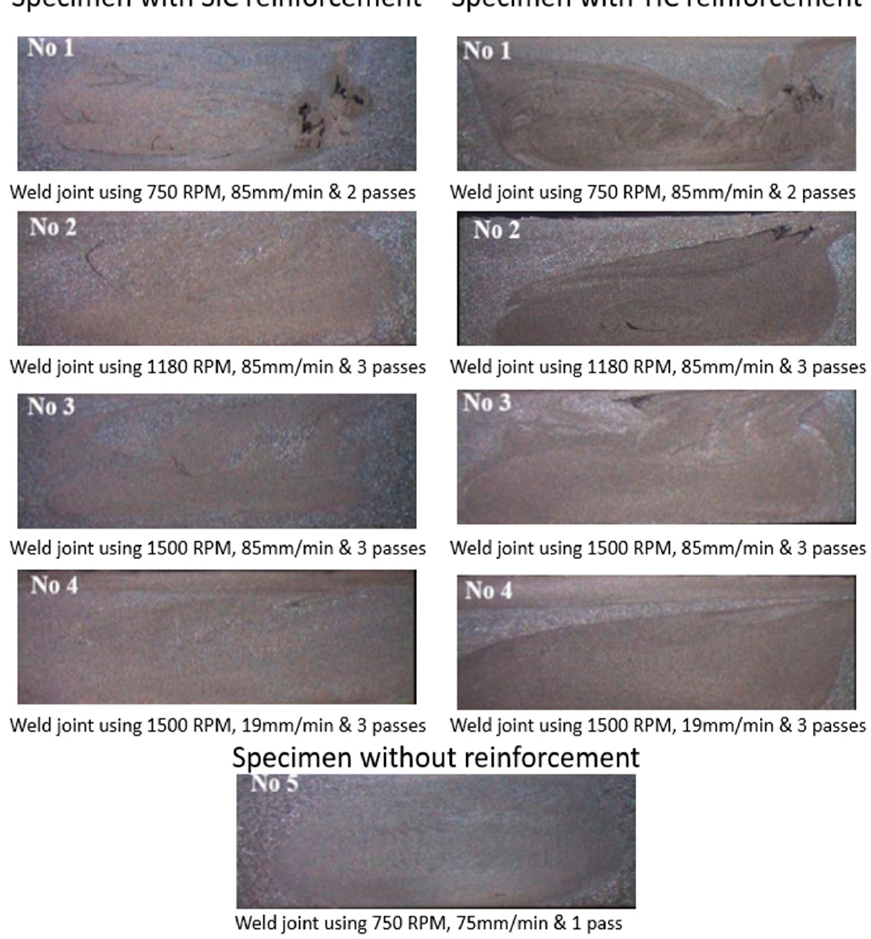
Figure 6. Macroscopic image of AA5083 joints with and without nanoparticle reinforcement [53]